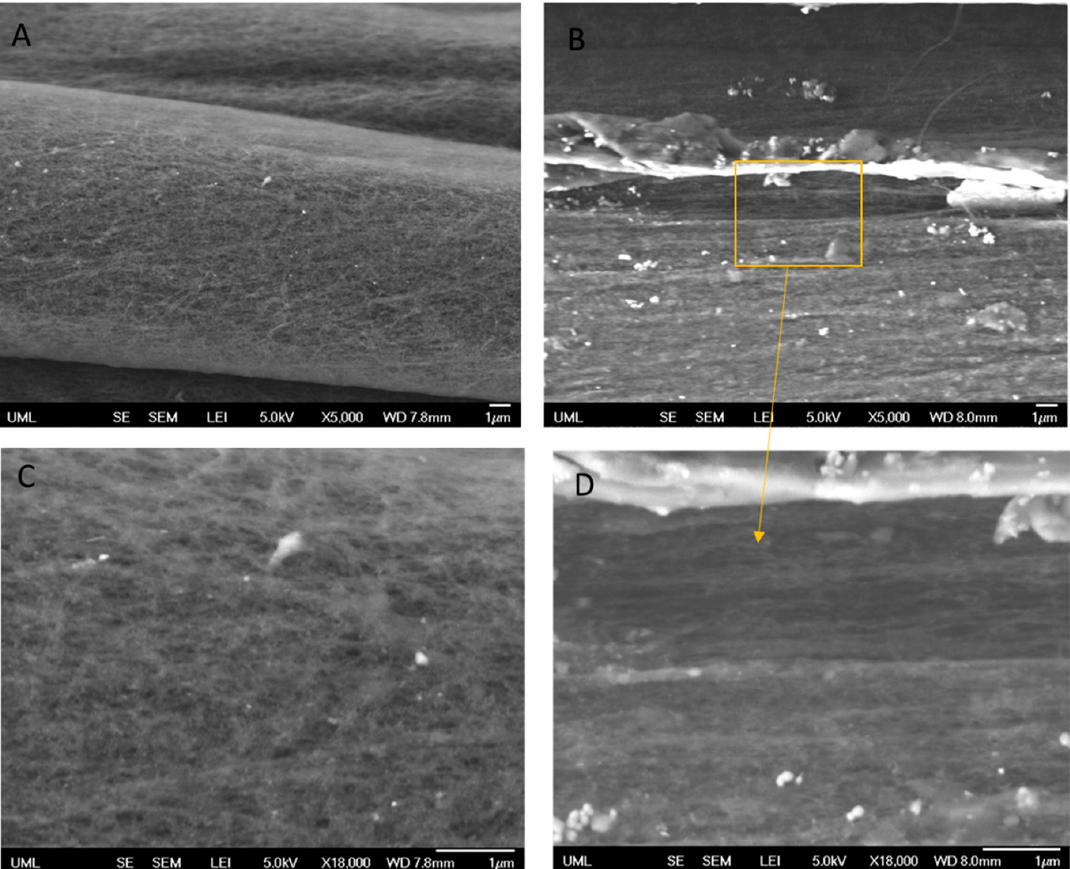
Figure 3. Untreated CNTY (side view) after uniaxial stretching to 2% strain ( A + C ) and 30% strain ( B + D ). The orange square focuses on a specific area of the image.